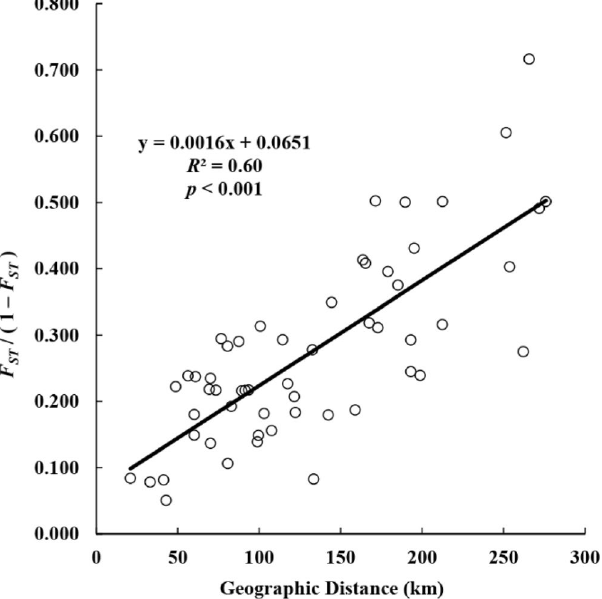
Figure 4. Isolation by distance plot among Karsenia koreana populations estimated based on microsatellite genotyping results. X and Y axis indicate geographic distance (km) and Slatkin’s linearized F ST (F ST / ( 1 − F ST )),